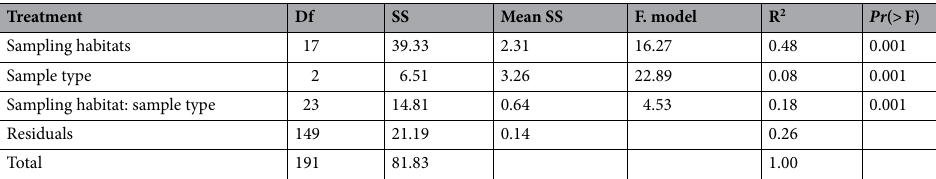
Table 1. PERMANOVA results based on Bray–Curtis dissimilarities evaluating differences in the bacterial community composition between sample type ( Aedes japonicus , Aedes triseriatus , and water samples) by individual sampling sites. P -values are based on 999 permutations.